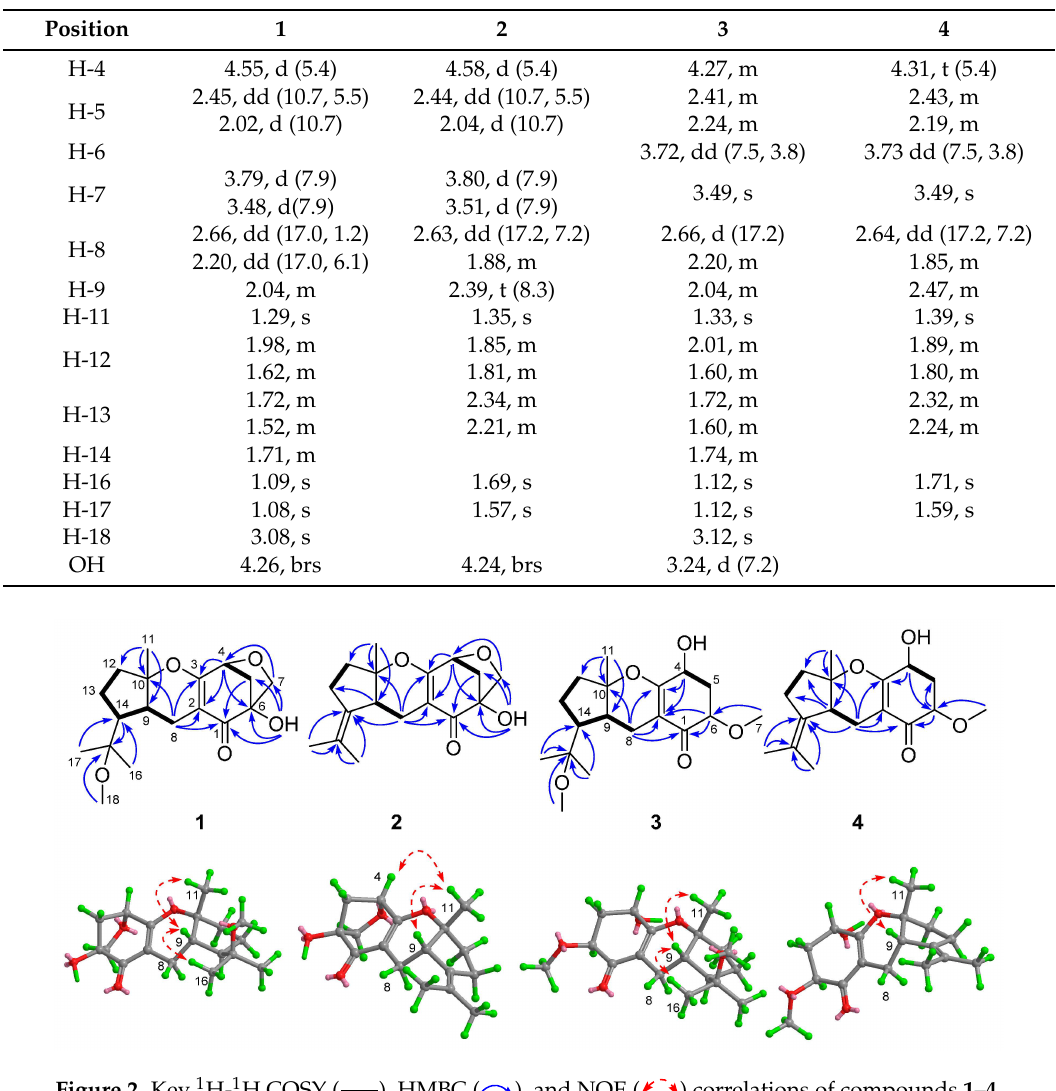
Figure 2. Key 1 H- 1 H COSY ( ), HMBC ( ), and NOE ( ) correlations of compounds 1 – 4 .